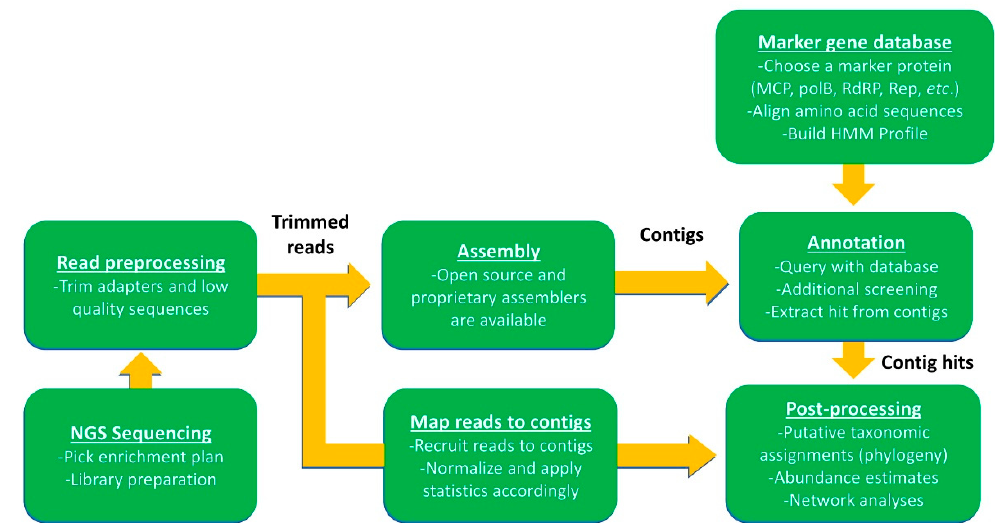
Figure 5. General bioinformatic pipeline using marker gene probing of community sequence data. This framework follows that used by Moniruzzaman et al., 2017 [12], where viral activity was assessed using marker gene detection from environmental mRNA. Though this framework was modeled off the cited study, it is flexible enough to incorporate both metagenomic and metatranscriptomic applications.